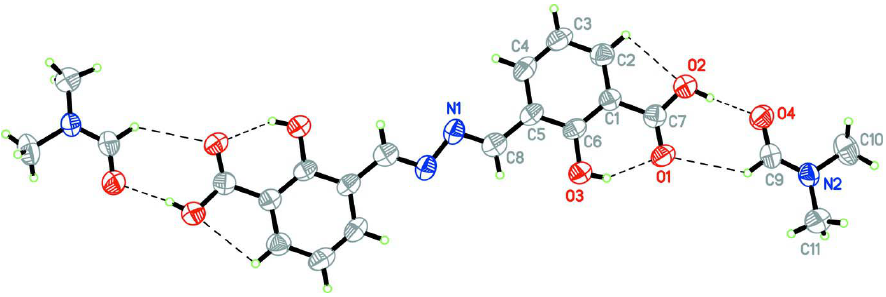
Figure 1 The molecular structure with displacement ellipsoids at the 30% probability level. Hydrogen bonds show as dashed lines. 2,2 ′ -Dihydroxy-3,3 ′ -[(1 E ,1 ′ E )-hydrazine-1,2- diylidenedimethylidyne]dibenzoic acid N , N